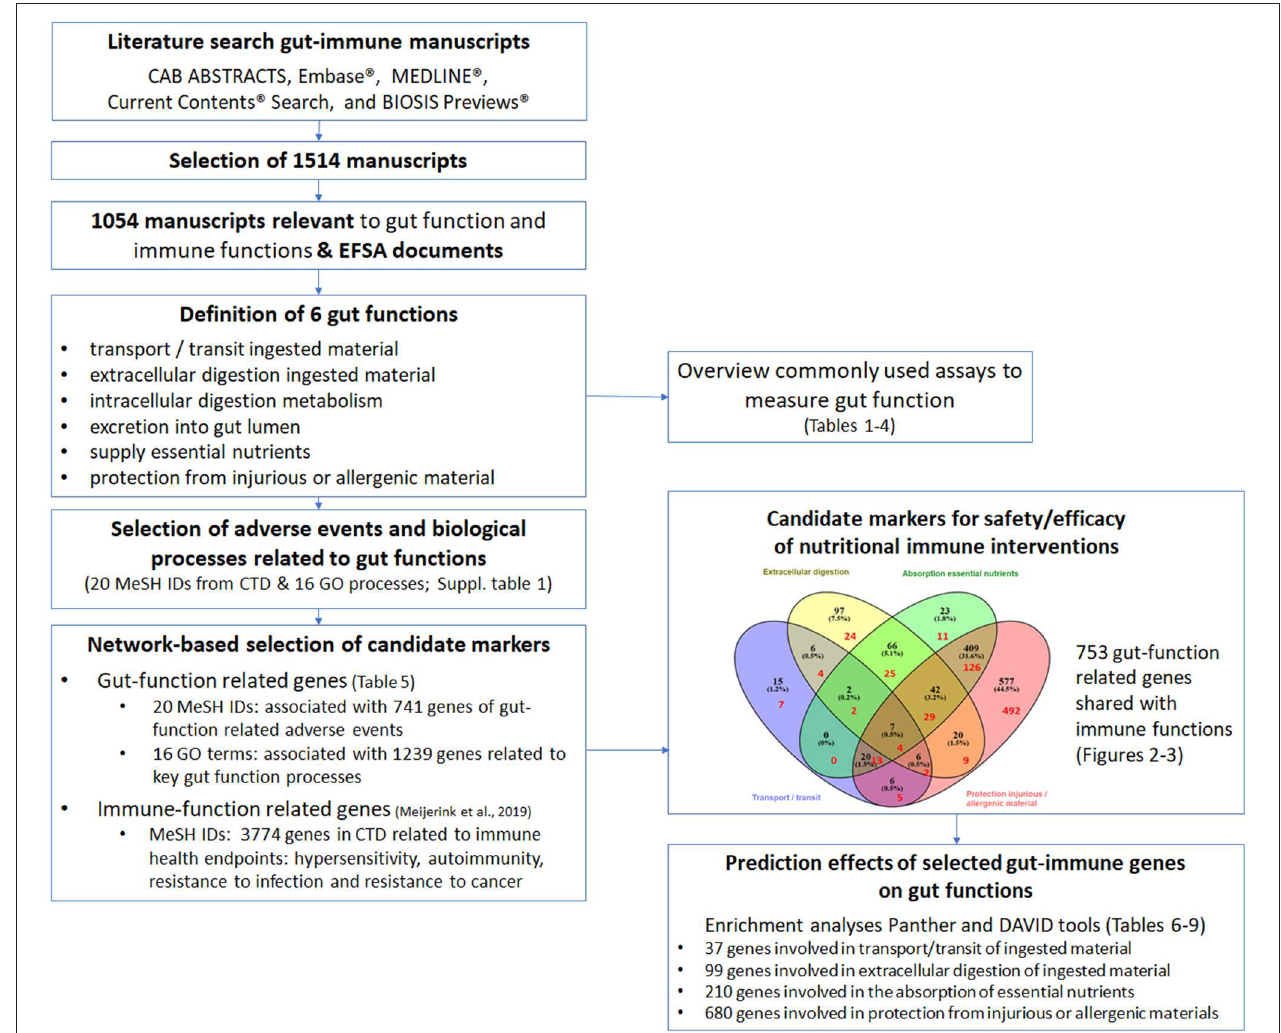
FIGURE 1 | Schematic overview of the work flow to identify gut-function related genes possibly affected by immune interventions and to identify commonly used assays to measure gut function. The literature search resulted in a total of 1,514 manuscripts, of which 1,054 manuscripts were considered relevant to gut and immune functions. The information from the 1,054 manuscripts was collected resulting in the definition of six key gut functions. An overview was made of the commonly used assays to study gut function (depicted in Tables 1 – 4 ). The adverse events related to malfunctioning of the gut and key biological processes related